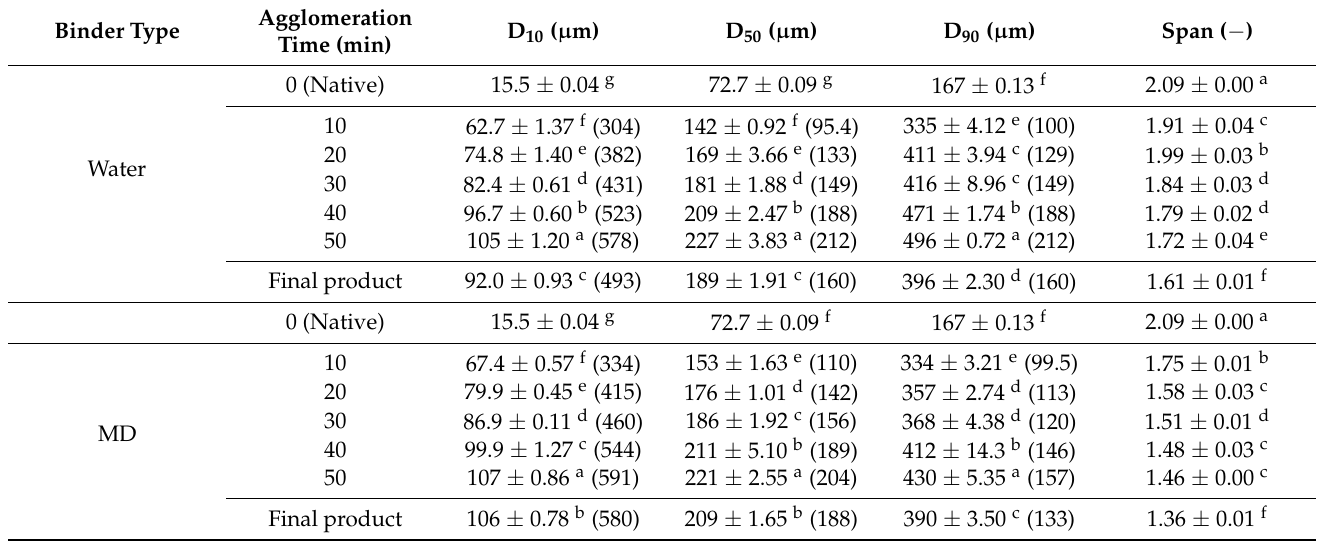
Table 1. PSD of XG agglomerates with different binders (water and MD) as a function of agglomera- tion